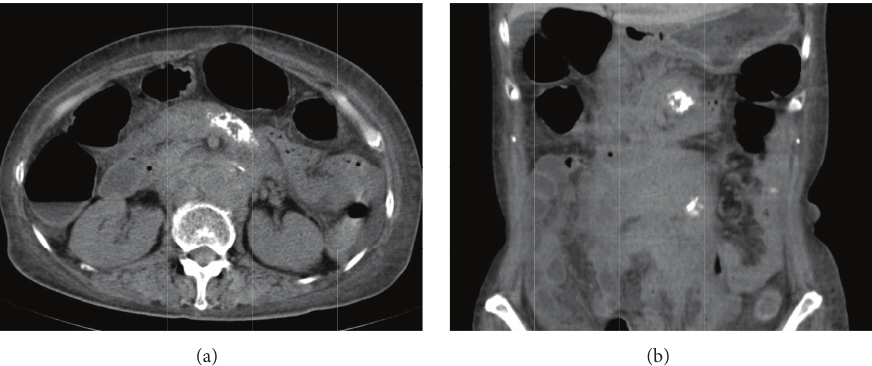
Figure 1: Abdominal computed tomography showing irregular soft tissue tumor masses with calcification in the abdominal aortic retroperitoneum and